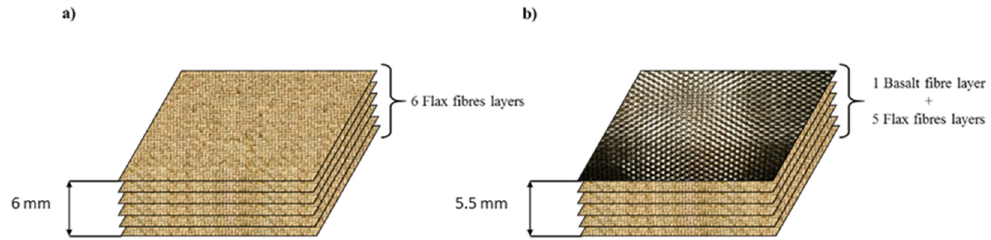
Figure 2. Formulation of laminates: ( a ) Flax / VE laminate with a thickness of 6 mm, and ( b ) flax / basalt / VE hybrid laminates with a thickness of 5.5 mm.